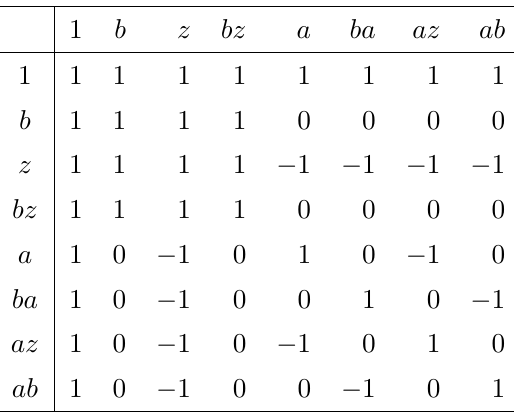
Table 8 . Table of values of T 2 twisted sector phases in a D 4 orbifold with discrete torsion. Non- commuting pairs are indicated with 0